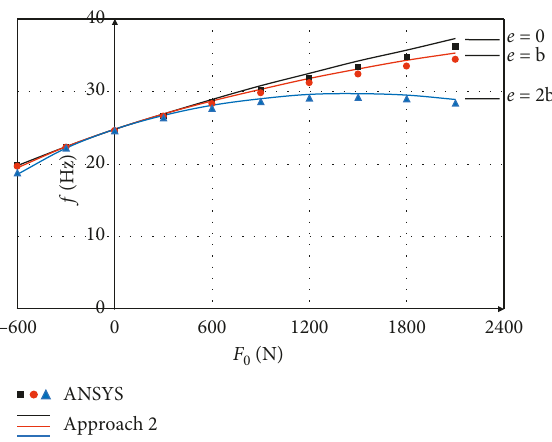
Figure 12: The first natural frequency with respect to different values of F 0 and e for the beam with laterally fixed ends by ANSYS APDL and Approach 2 (equation